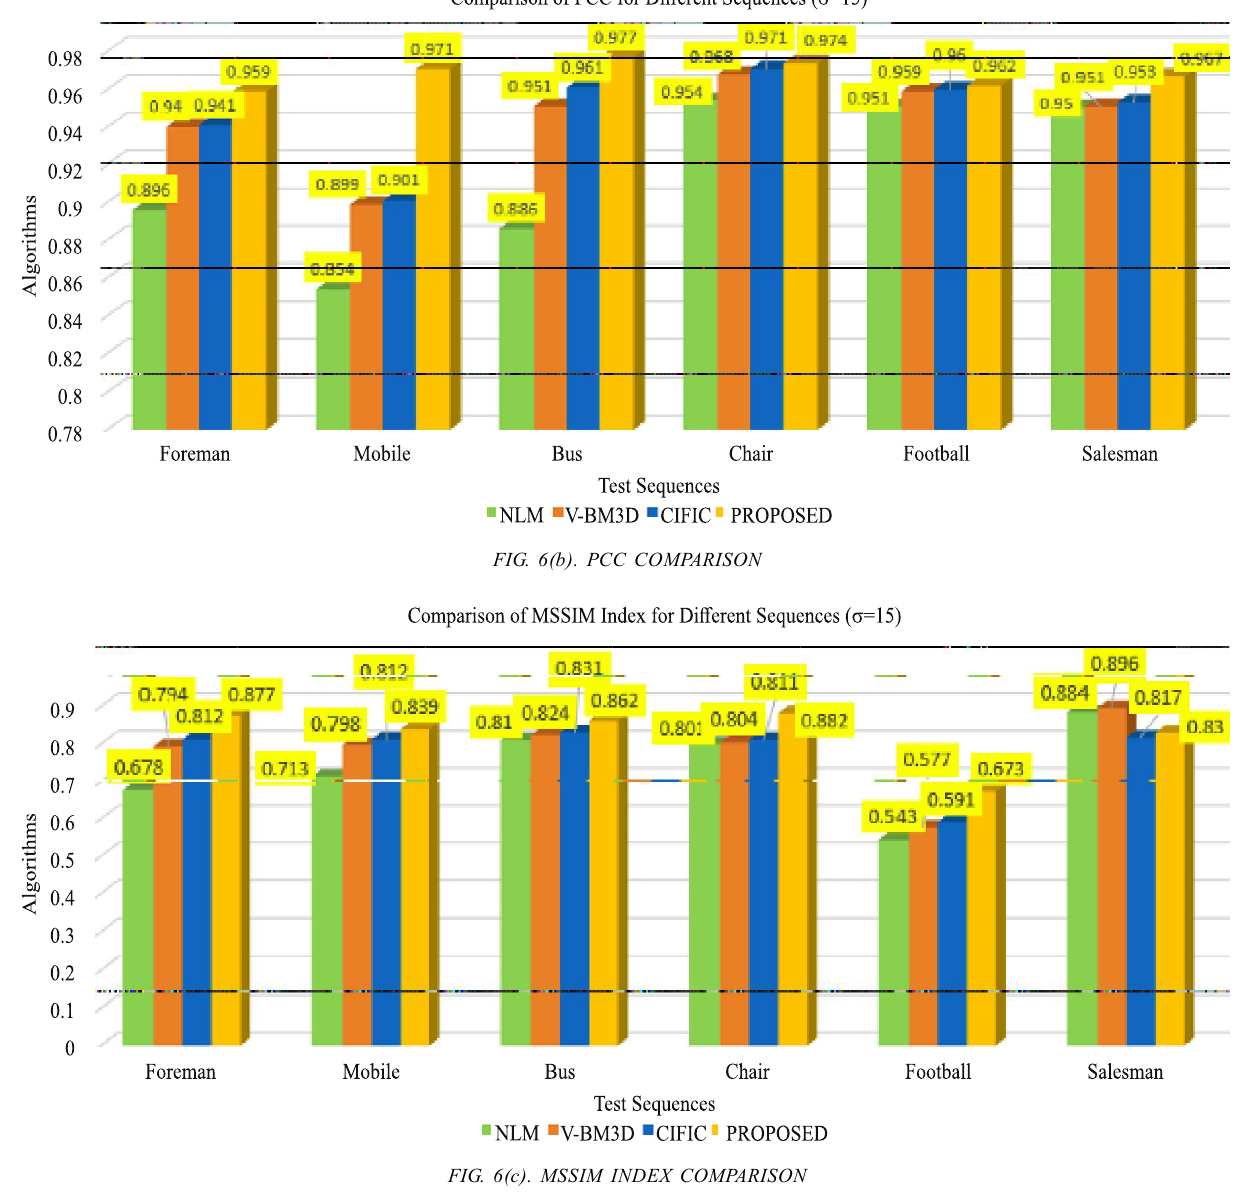
FIG. 6. GRAPHICAL COMPARISON OF DIFFERENT VIDEO SEQUENCES USING DIFFERENT